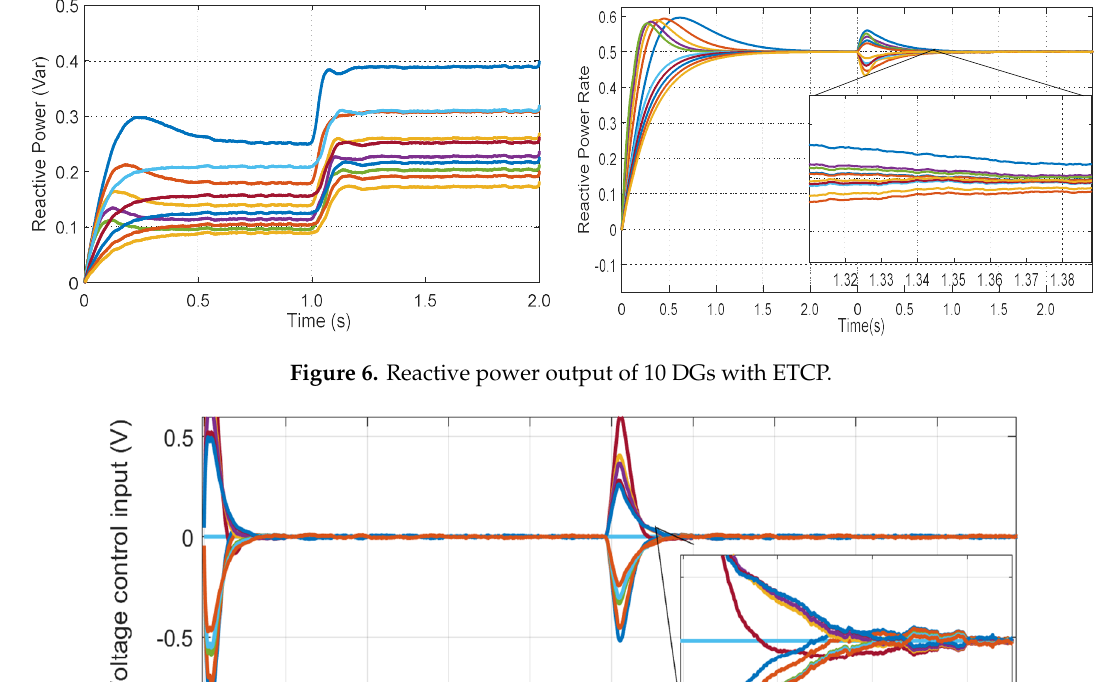
Figure 5. Reactive power output of 10 DGs with periodic communication